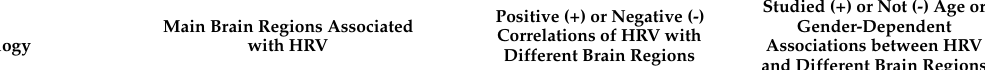
A key component of the BOLD signal, the hemodynamic response function (response height, time to peak and full width at half maximum) were